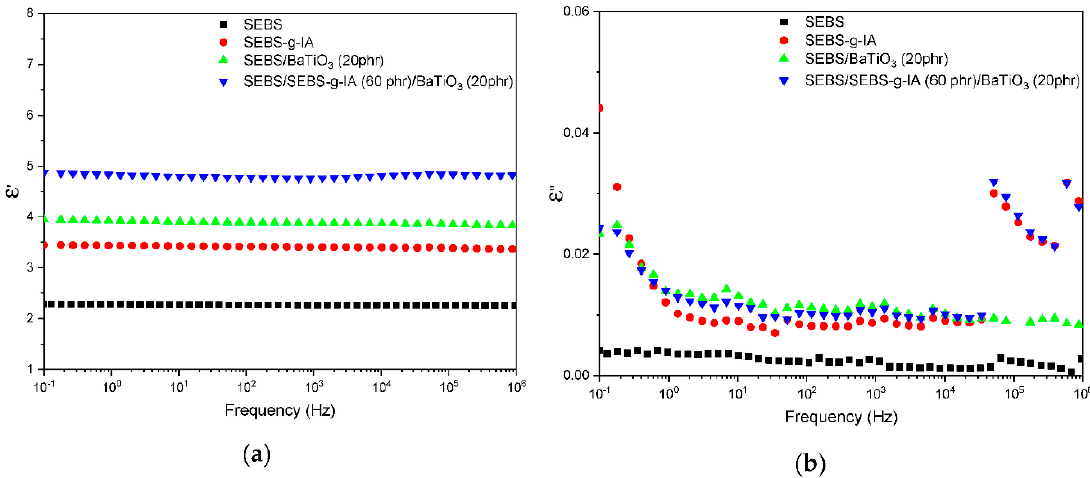
Figure 8. Dielectric permittivity ( a ) and dielectric loss ( b ) as function of frequency of SEBS-BaTiO 3 composites studied.